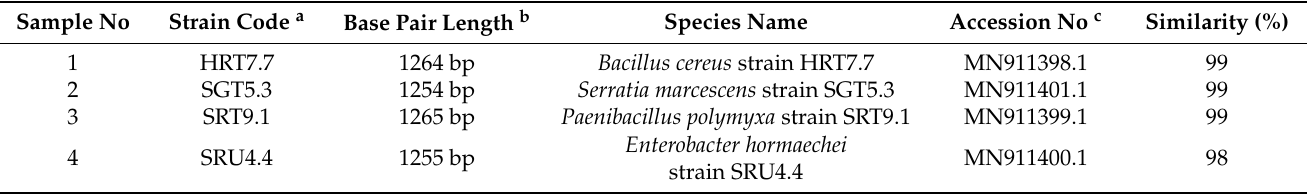
Table S3). Interestingly, the inhibitory potential of the control was significantly ( p < 0.05) lower than all of the newly identified antagonistic strains (Table S4). Table 1. Molecular identification of 16S rRNA gene of epiphytic bacterial strains with in vitro antagonistic traits. Sample No